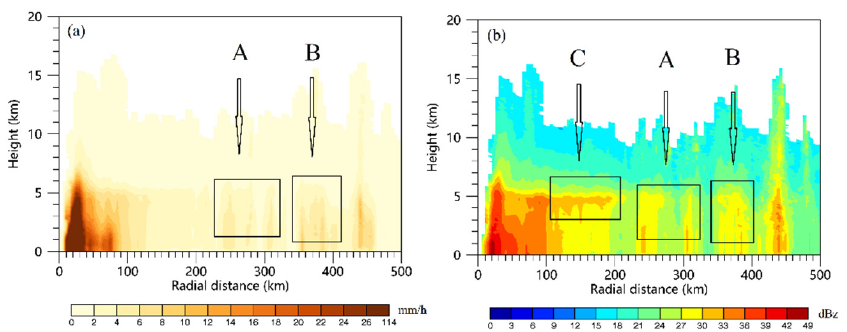
Figure 6. Radial distribution of tangential mean precipitation intensity ( a ) mm h − 1 and mean reflectivity ( b ) dBz within 500 km from the typhoon center based on the GPM-DPR data (17:00 on 6 July).